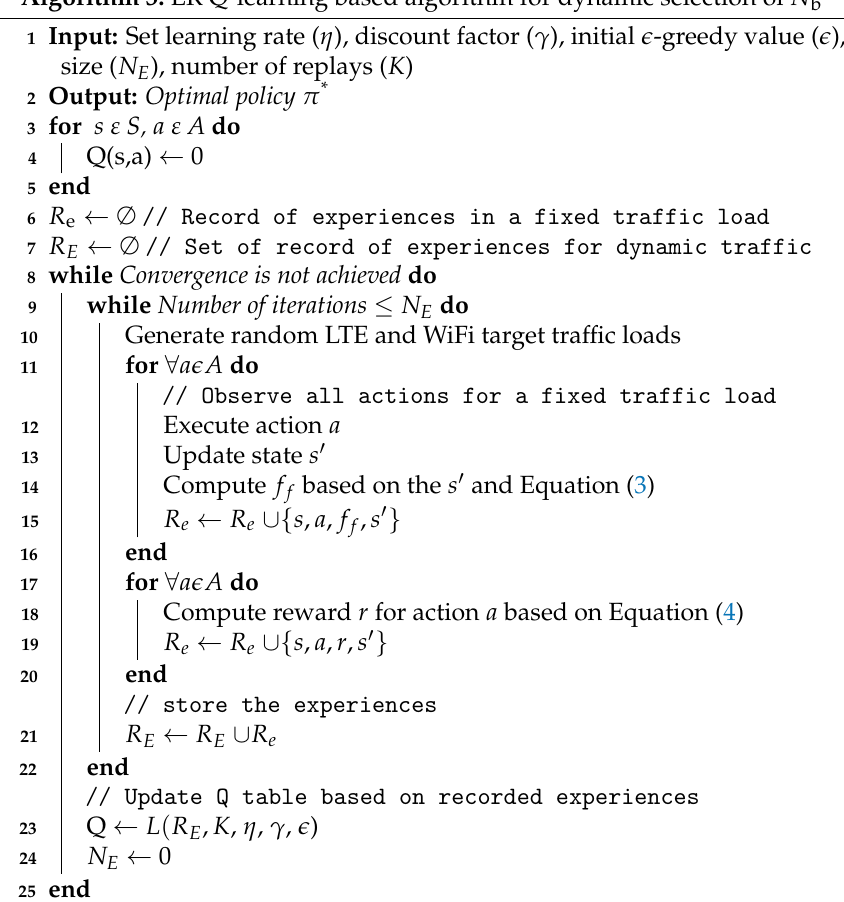
Algorithm 3: ER Q-learning based algorithm for dynamic selection of N